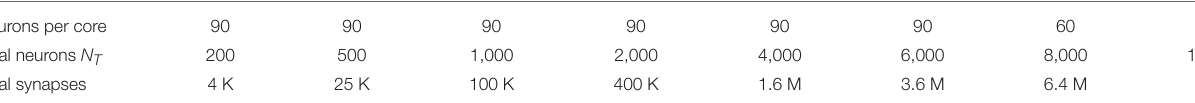
TABLE 3 | Effects of scaling conditioning network.